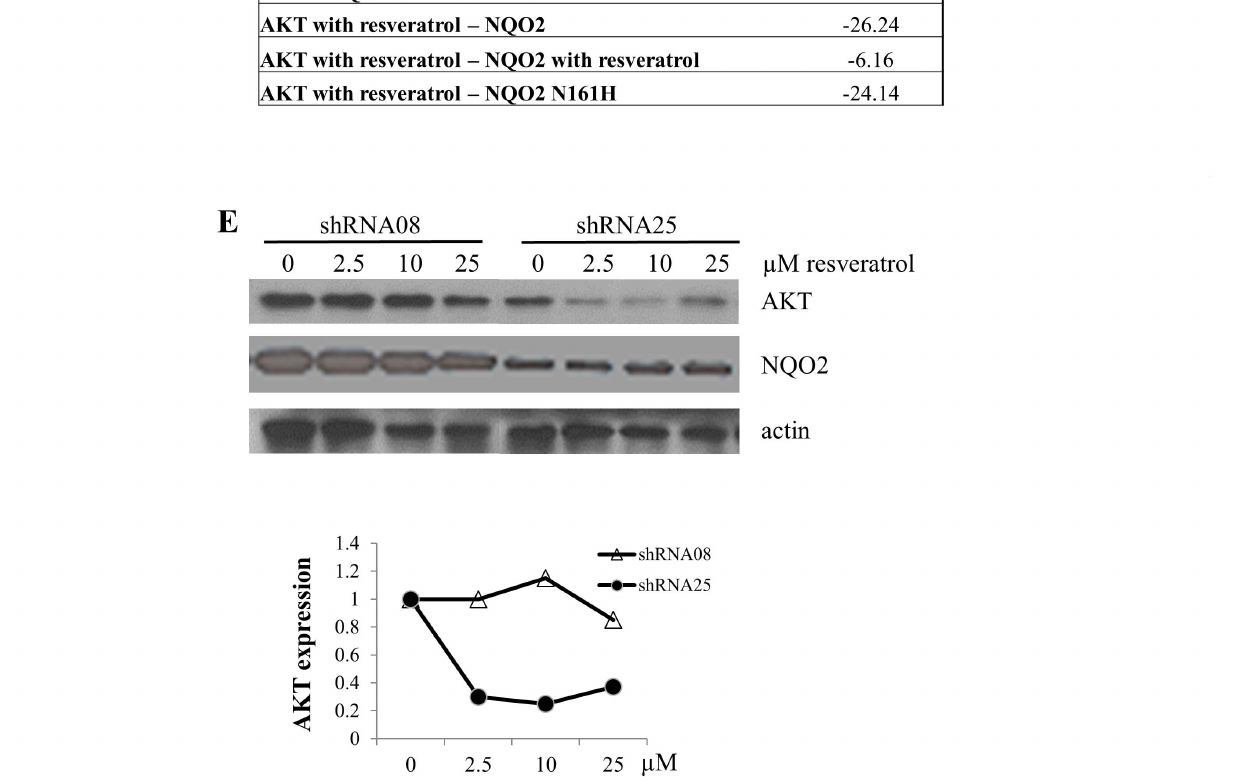
Figure 3. Binding of resveratrol to AKT. ( A ) Docking of resveratrol to AKT (top panel) using DOCK 6.3 program. The grid score (GS) represented the sum of the van der Waals (VDW) and electrostatic scores (ES); compounds showing low GS are likely to have a high affinity towards the receptor (targeting protein). The affinity of resveratrol and ATP to AKT was compared and shown in lower panel. ( B ) Binding of specific proteins from K562 cell extracts to immobilized resveratrol affinity columns and isolation of resveratrol target proteins. Cell lysates fractionated on control and resveratrol